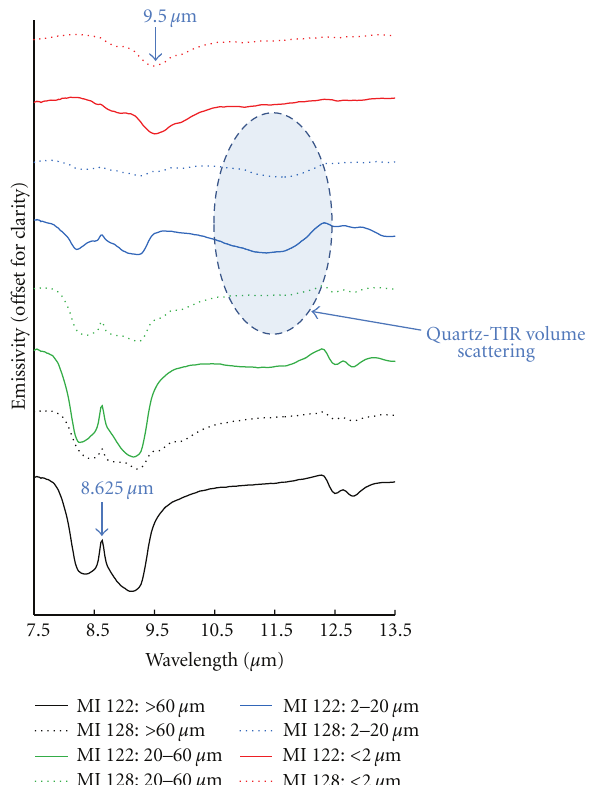
Figure 4: Example MicroFTIR emissivity spectra of particle size separated Tick Hill soil samples showing diagnostic mineral and textural related spectral